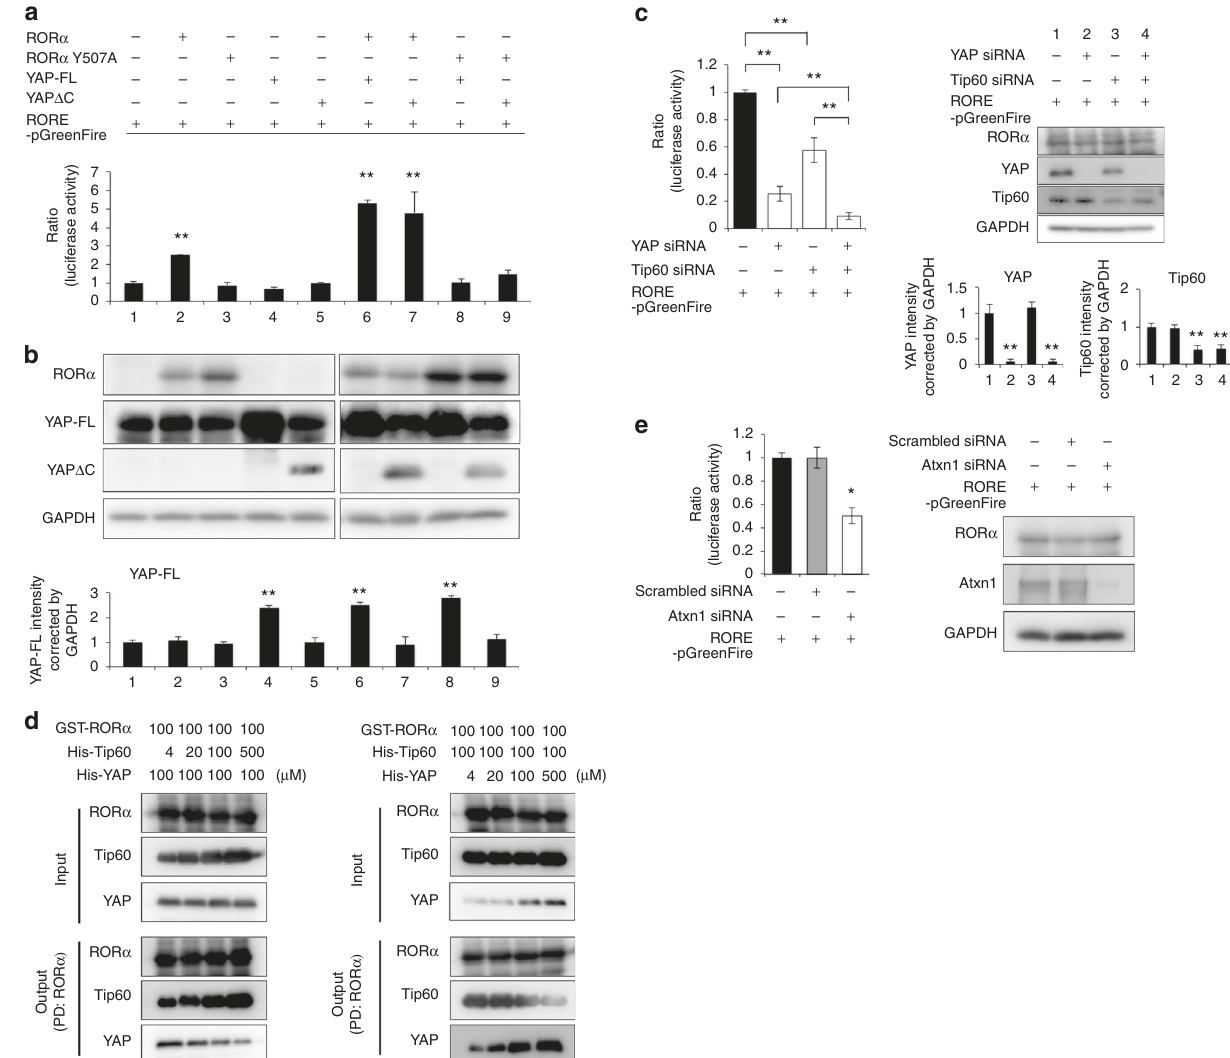
Fig. 5 YAP/YAPdeltaC are co-factors of ROR α . a Luciferase assays with COS-7 cells showing that ROR α but not mutant ROR α (ROR α Y507A) lacking the consensus motif for the WW domain of YAP, acts with YAP or YAPdeltaC to transactivate luciferase gene expression via the ROR α -responsive element. Single transfection of YAP or YAPdeltaC expression vector yielded insuf fi cient transactivation. Double asterisks indicate statistical signi fi cance ( p < 0.01, N = 5) in one-way ANOVA with post hoc Tukey ’ s HSD test. b Protein expression levels of ROR α , YAP, and YAPdeltaC in the luciferase assays shown in Fig. 5a, determined by western blot. Because YAP is expressed endogenously in COS-7 cells, the amount of YAP was quanti fi ed ( N = 5). c Left: effect of YAP knockdown and/or Tip60 knockdown on ROR α -mediated transcription, evaluated by luciferase assays in 293T cells expressing ROR α . Asterisks indicate statistical signi fi cance ( p < 0.05, N = 8) in one-way ANOVA with post hoc Tukey ’ s HSD test. Right: levels of ROR α , YAP, YAPdeltaC, and Tip60 are shown in lower panels. Double asterisks indicate statistical signi fi cance ( p < 0.01, N = 5) in one-way ANOVA with post hoc Tukey ’ s HSD test. d Pull- down assay showing that YAP and Tip60 compete for interaction with ROR α . A GST fusion protein of a part of ROR α (a.a. 424 – 523) was used in this assay, as described in Methods. e Effect of Atxn1 knockdown on ROR α -mediated transcription, evaluated by luciferase assays in 293T cells expressing ROR α . Expression levels of ROR α and Atxn1 are shown in right panel. Asterisks indicate statistical signi fi cance ( p < 0.05, N = 6) in one-way ANOVA with post hoc Tukey ’ s HSD The similar experiments with 293T cells, which express ROR α down with His-YAP (Fig. 4c, lower panels). On the other hand, endogenously, at 2 days after transfection supported that normal similar pull-down experiments did not reveal a direct interaction and mutant Atxn1 equally interact with YAP/YAPdeltaC between GST-Atxn1 and ROR α , as reported previously 12 . Because ROR α co-precipitated with normal but not mutant (Supplementary Fig. 1C, D). Again, ROR α co-precipitated with Atxn1 (Fig. 4a, b), and a direct interaction between Atxn1 and normal but not mutant Atxn1, suggesting perturbation of YAP ROR α was not con fi rmed in a previous report 12 , we hypothesized integration into the ROR α – YAP – Atxn1 ternary complex by that the ROR α – YAP – Atxn1 ternary complex forms via mutant Atxn1. ROR α – YAP and YAP – Atxn1 direct interactions. The ternary complex formed ef fi ciently with normal Atxn1, but to a lesser extent with mutant Atxn1, suggesting that mutant Atxn1 might perturb integration of YAP into the ternary complex. we investigated whether YAP/YAPdeltaC function as a